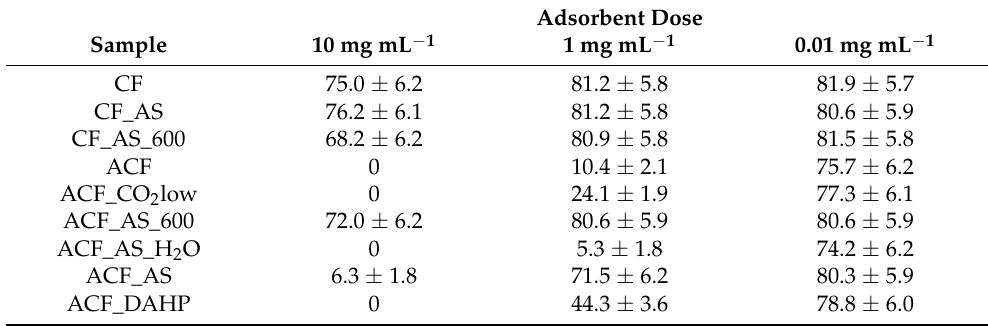
Table 8. AChE inhibition of dimethoate solutions (initial inhibition with 5 × 10 − 4 mol L − 1 dimethoate solution was 85 ± 2.6%) after the adsorption process with adsorbent doses of 10 mg mL − 1 , 1 mg mL − 1 , and 0.01 mg mL − 1